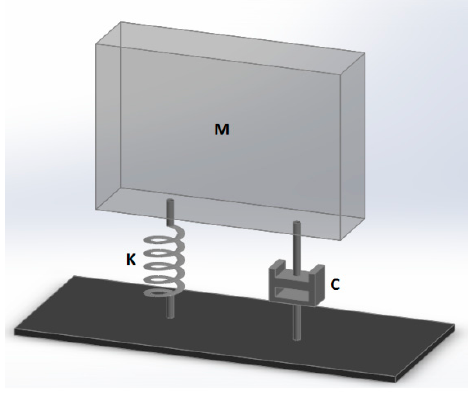
Figure 1. General one-degree-of-freedom system: mass M , spring with K stiffness and damping element C .